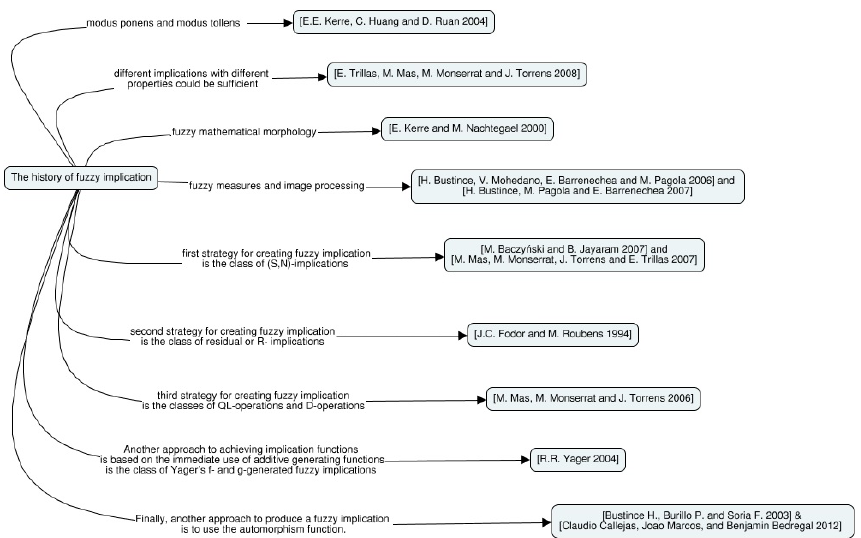
Figure 8. The history and evolution of fuzzy